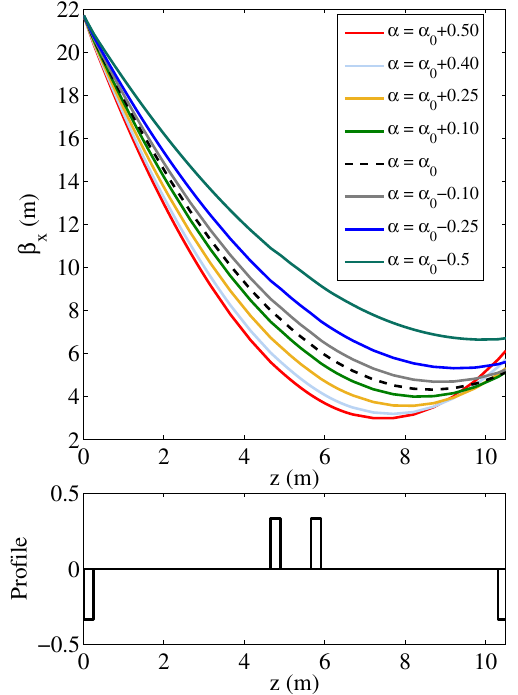
FIG. 15. Simulated beam optics along the bunch compressor (top) for the scan shown in Fig. 16 and schematic layout of the SITF bunch compressor lattice (bottom).